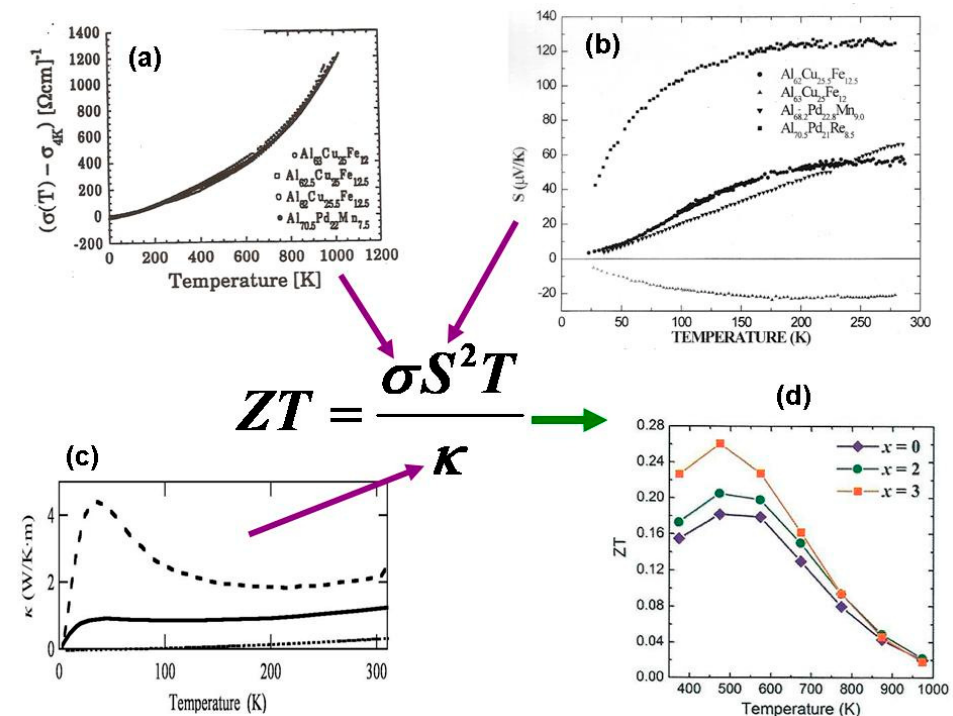
Figure 11. Collage picture illustrating the contribution of each transport coefficient (magenta arrows) to the resulting ZT value (green arrow). Note that panels ( a )–( d ) correspond to different i-QCs representatives, each one showing an optimal behavior for the considered physical magnitude: ( a ) Temperature dependence of the electrical conductivity for four different i-QCs up to 1000 K. (Reprinted figure with permission from Mayou, D.; Berger, C.; Cyrot-Lackmann, F.; Klein, T.; Lanco, P. Evidence for unconventional electronic transport in quasicrystals. Phys. Rev. Lett. 1993, 70, 3915-3918. Copyright (1993) by the American Physical Society); ( b ) temperature dependence of the Seebeck coefficient for different i-QCs. (Courtesy of Roberto Escudero); ( c ) temperature dependence of the thermal conductivity for the i-Al 74.6 Re 17.4 Si 8 QC (solid line) and its 1 / 1-cubic approximant (dashed line). The contribution due to the electrons (estimated from the Wiedemann–Franz law, dotted line) is almost negligible as compared to that due to the phonons (Courtesy Tsunehiro Takeuchi); ( d ) figure of merit (ZT) curves as a function of temperature for Al 71 − x Ga x Pd 20 Mn 9 (x = 0, 2, 3). (Reprinted from Takagiwa, Y.; Kirihara, K. Metallic-covalent bonding conversion and thermoelectric properties of Al-based icosahedral quasicrystals and approximants. Sci. Technol. Adv. Mater. 2014, 15, 044802; doi:10.1088 / 1468-6996 / 15 / 4 / 044802, Creative Commons